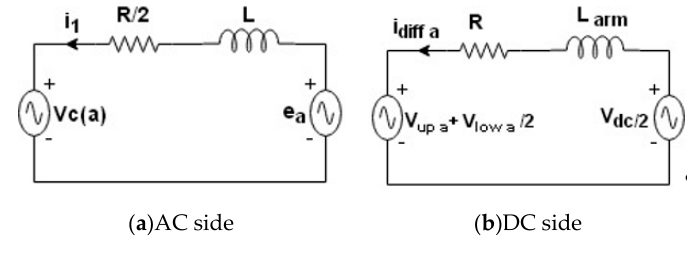
Figure 3. Single phase equivalent circuit.